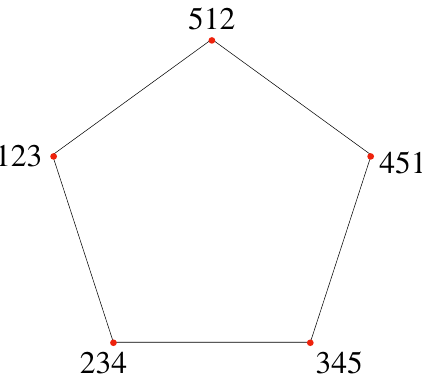
Figure 1 . 5-pt intersecting